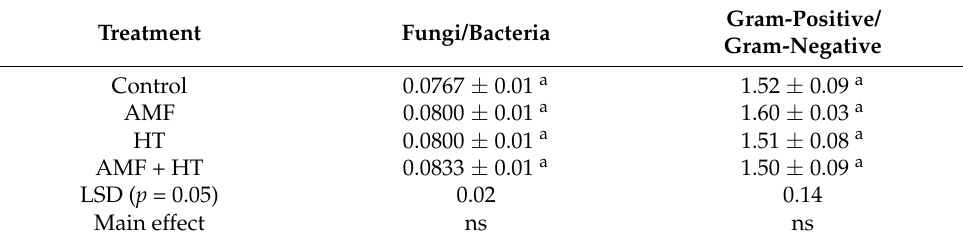
Table 4. The effect of high-temperature stress on fungi/bacteria-specific PLFA community analyzed in maize rhizosphere. Treatment Fungi/Bacteria